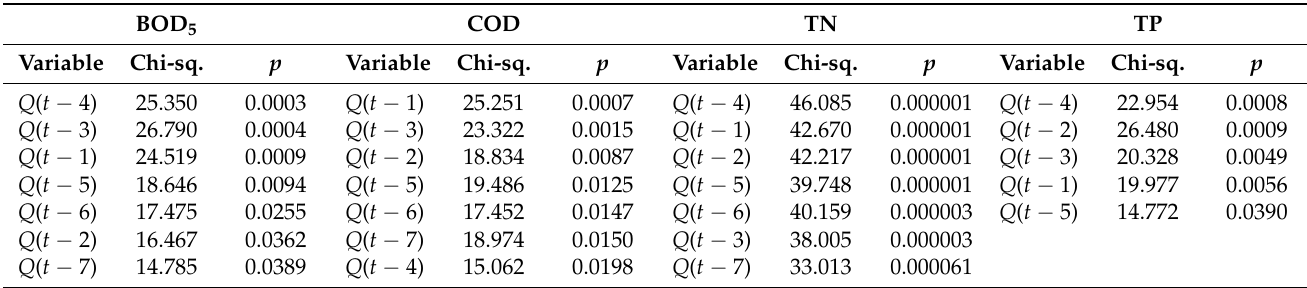
Table 2. List of Chi-squared test values and p -test probabilities for variables describing wastewater quality indicators (BOD 5 , COD, TN, TP ) in models for identifying minimum C ( { t ) } f values for the Sitk ó wka-Nowiny wastewater treatment plant.